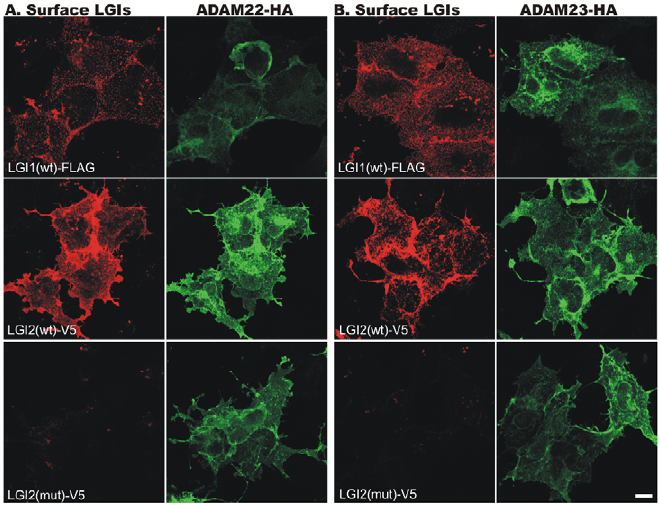
Figure 4. Wild-type (wt) LGI2, like LGI1, binds to ADAM22 and ADAM23 on the cell surface. Indicated cDNAs were co-transfected into COS7 cells, and after 24 hours surface-bound LGI1-Flag and LGI2-V5 (red) were labeled before cell permeabilization and staining of the HA-tagged ADAM22 (A) and ADAM23 (B) proteins (green). Wt Lgi1 and LGI2 bound to both cell surface ADAM receptors, whereas mutant LGI2 was not secreted and did not bind the receptors.